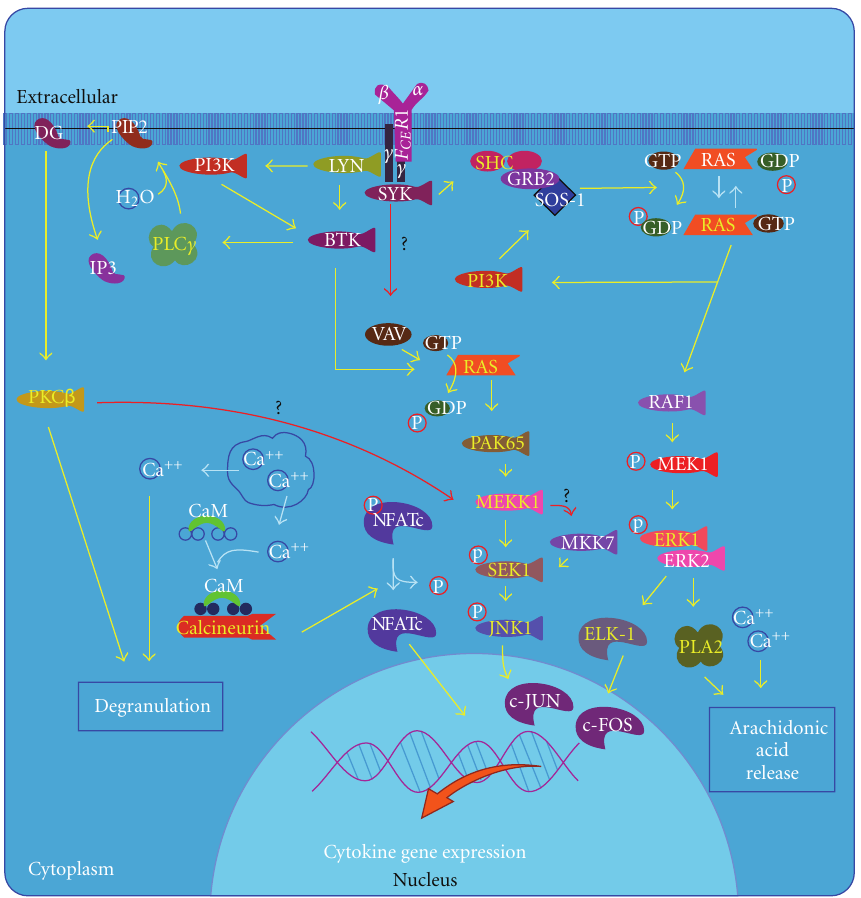
Figure 3: Fc epsilon receptor I signaling in mast cell pathway extracted from BioCarta database